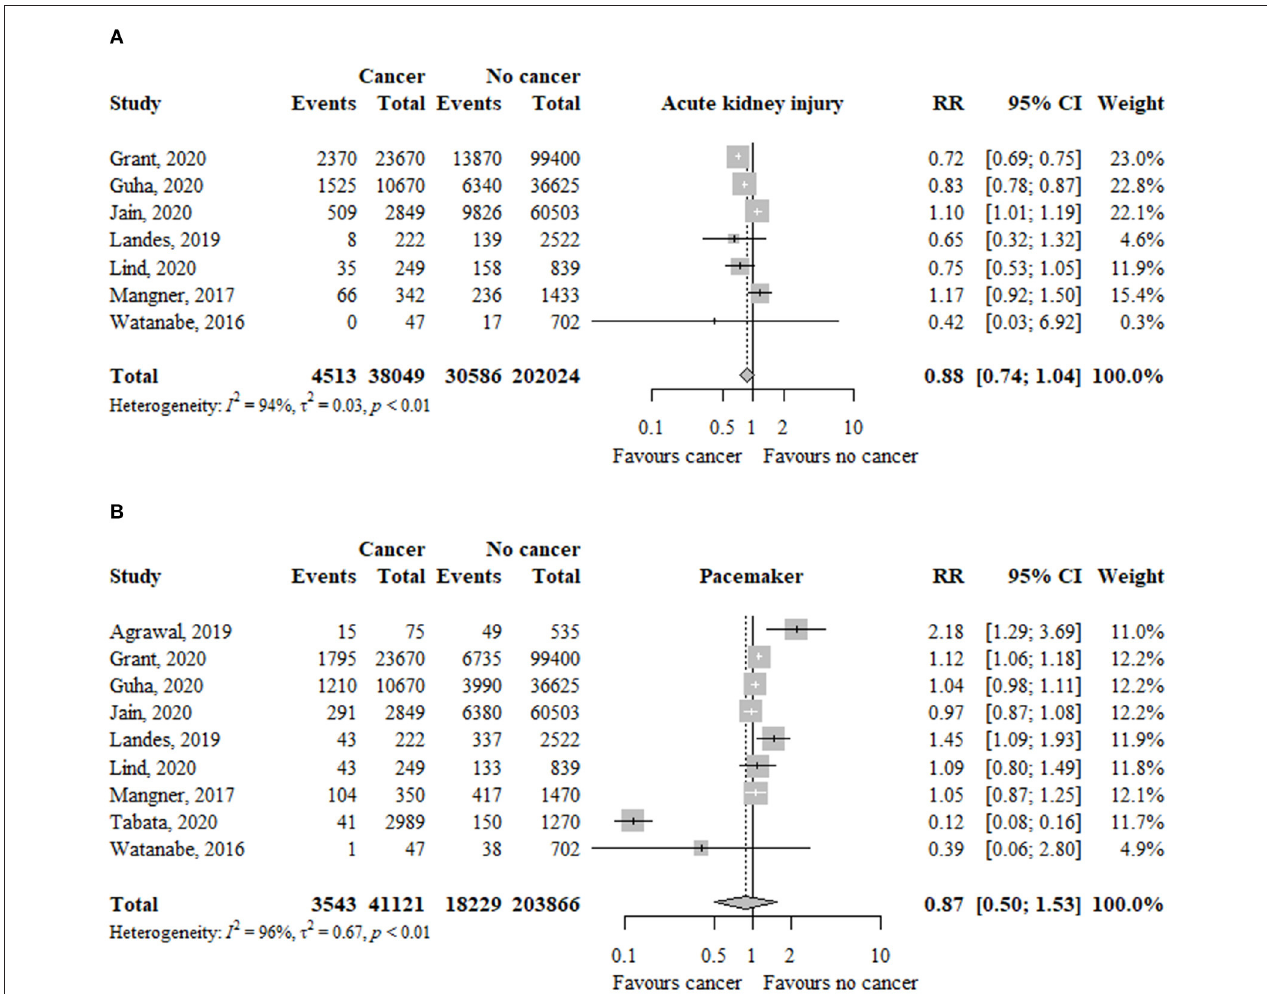
FIGURE 5 | Association between cancer and (A) major bleeding and (B) vascular complications in TAVR patients. RR, relative risk; aHR, adjusted hazard ratio; CI, confidence interval; TAVR, transcatheter aortic valve